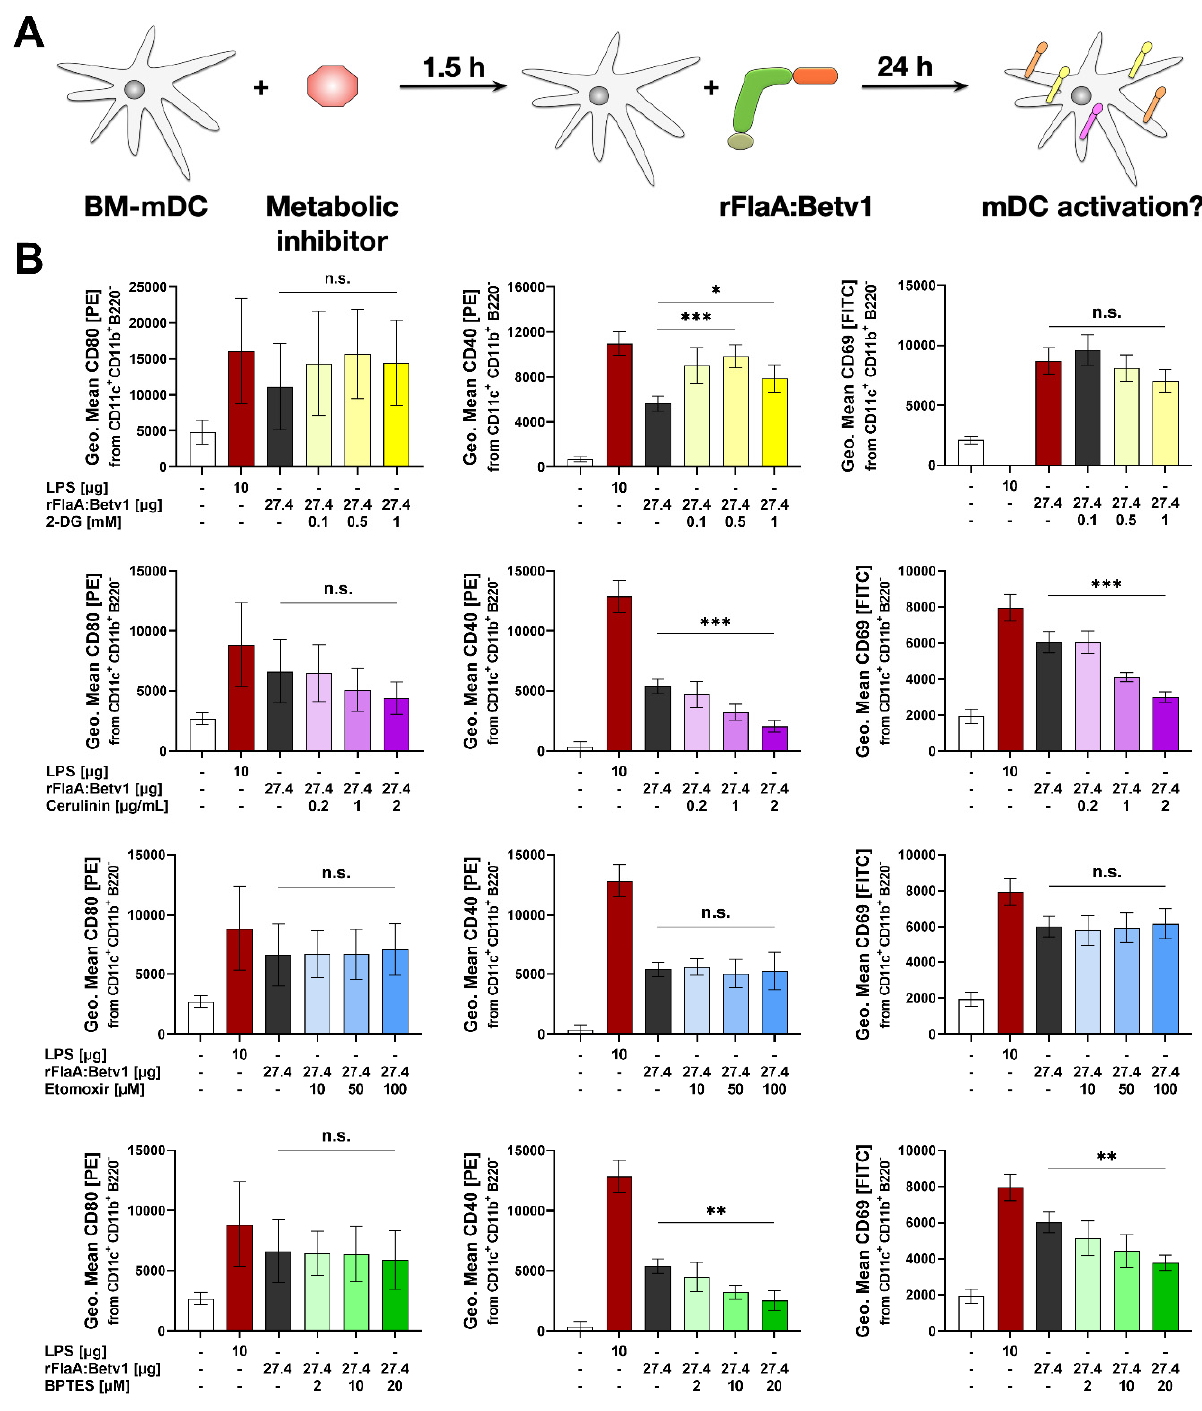
Figure 5. Glycolysis, fatty acid synthesis, and amino acid metabolism contribute to rFlaA:Betv1- induced expression of co-stimulatory molecules. mDCs were pretreated for 90 min with the indicated inhibitor concentrations, followed by stimulation with 27.4 µ g/mL of rFlaA:Betv1 for 24 h ( A ). Cells were harvested, and surface expression of the indicated co-stimulatory molecules was quantified as geometric mean fluorescence intensities (MFI) by flow cytometry. Data are results of three to four independent experiments ( B ). Statistical comparisons were performed by 2-way ANOVA with correction for multiple comparisons according to Turkey and indicated as: n.s. p -value > 0.05, * p -value < 0.05, ** p -value < 0.01, or *** p -value < 0.001.